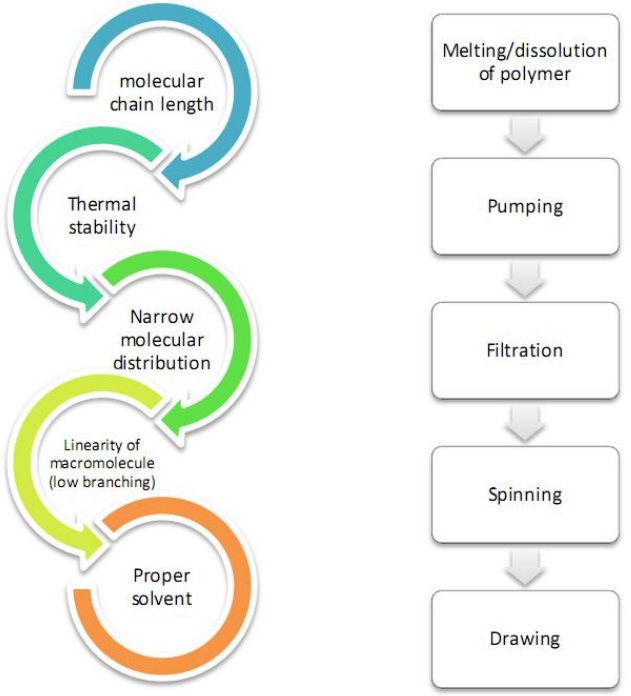
Figure 3. Some important properties of polymers for ensuring spinnability and simplified scheme of steps during spinning. Table 2. Overview of the most utilized spinning techniques for cellulose nanofiber preparation, most common precursors and solvents used, and application of produced fibers.